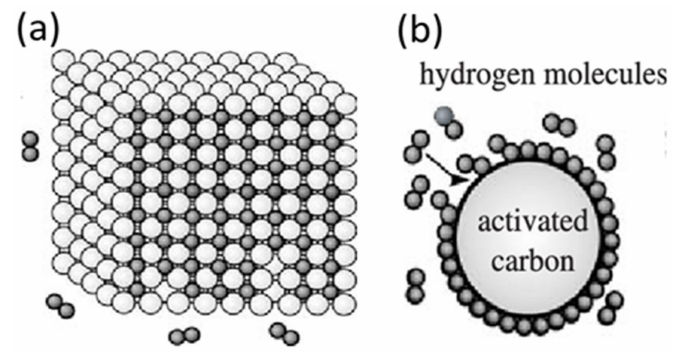
Figure 1. Schematic of hydrogen ( a ) absorption mechanism in chemisorption materials and ( b ) adsorption mechanism in physisorption materials